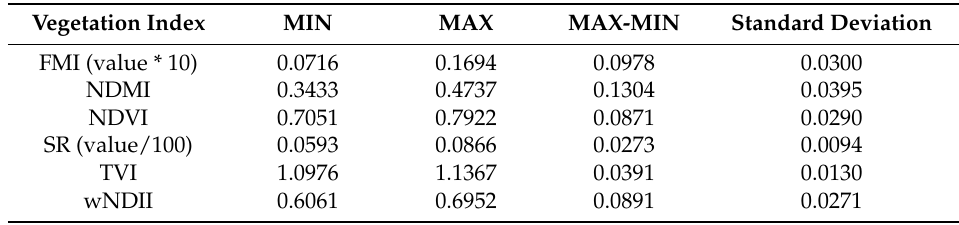
Table 9. Statistical information about the average values in the areas with minimal disturbance in the Sumava